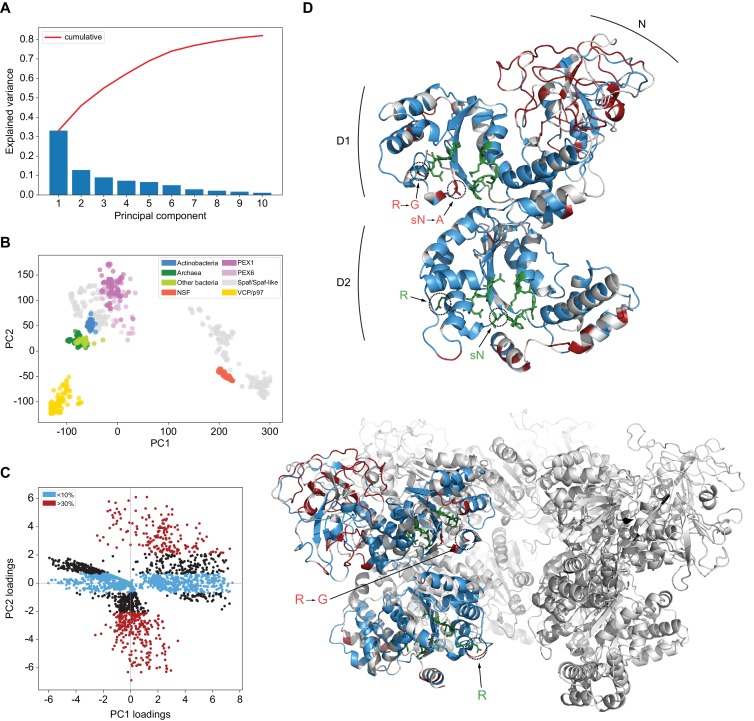
Principal component analysis of Cdc48 family protein sequences.(A) 80% of the total variance between sequences can be explained by the first 10 principal components (PCs). The fraction of variance explained by distinct PCs is shown as a bar diagram (in blue) and the cumulative variance is shown as a red line. (B) PCA scores plot of the first two components. Cdc48 family proteins group into discrete clusters in accordance with their previously assigned category. The first principal component allows for the best distinction between NSF and Spaf types of sequences from the rest of the family members, while the second PC can be used to best distinguish between eukaryotic p97, archaeal/bacterial Cdc48(-like) sequences, PEX1 and PEX6 as well as Spaf-like proteins. (C) PCA loadings plot of the first two principal components. The dots colored in red represent the alignment positions for which the distance to 0 on the second PC loading exceeded the cutoff of 30% of the maximum distance (positions with most variance) while the dots colored in blue represent positions where the cutoff was set to 10% and lower (positions with least variance). (D) Structural model of the rhodococcal Cpa generated using human p97 as a template. Positions with most variance (as shown in panel C) are colored red and positions with least variance (most conserved) are colored in blue. The Walker A and B motifs, as well as arginine finger and sensor asparagine are shown using stick representation and colored green when considered conserved and red when considered variable. Top: protomer view with locations of the N-domain, D1- and D2-modules indicated. Bottom: hexamer view (the front protomer not shown). R – arginine finger, sN – sensor asparagine, A – alanine. The designation X→Y denotes substitution of amino acid X to amino acid Y in the original sequence.